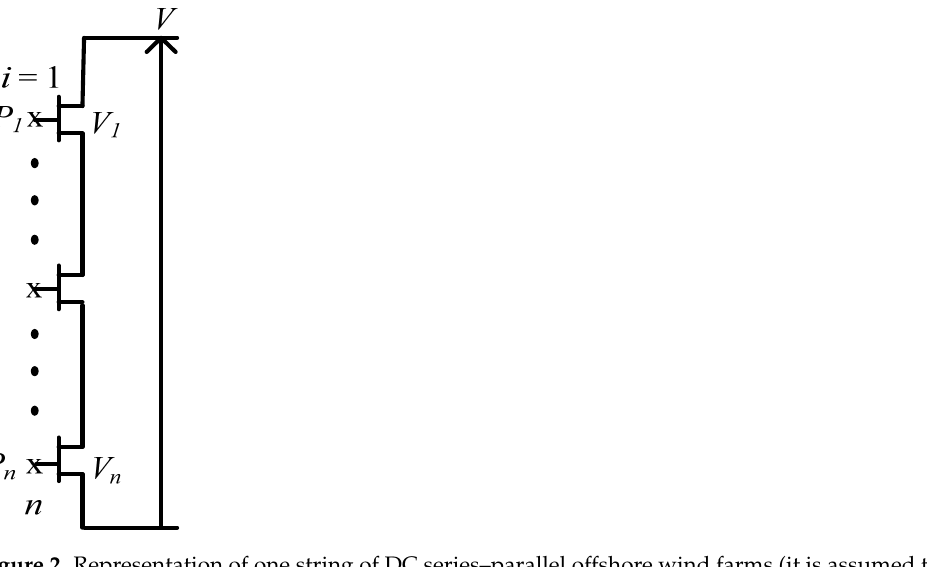
Figure 2. Representation of one string of DC series–parallel offshore wind farms (it is assumed that P 1 ≥ P 2 ≥ · · · ≥ P n ) .